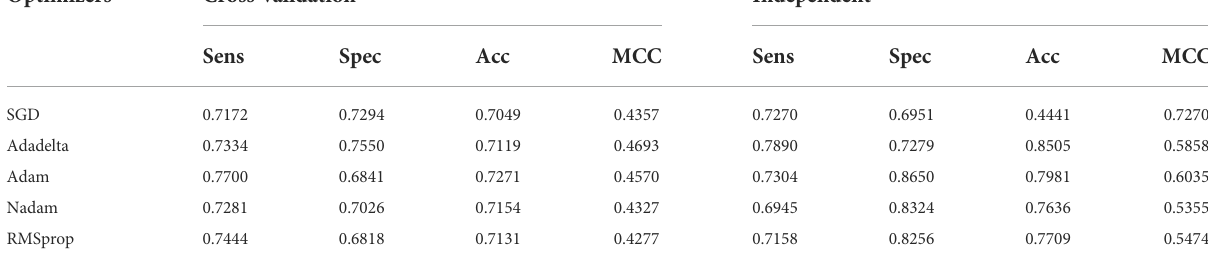
TABLE 5 DDE model predicted performance of UPP with different optimizers. Optimizers